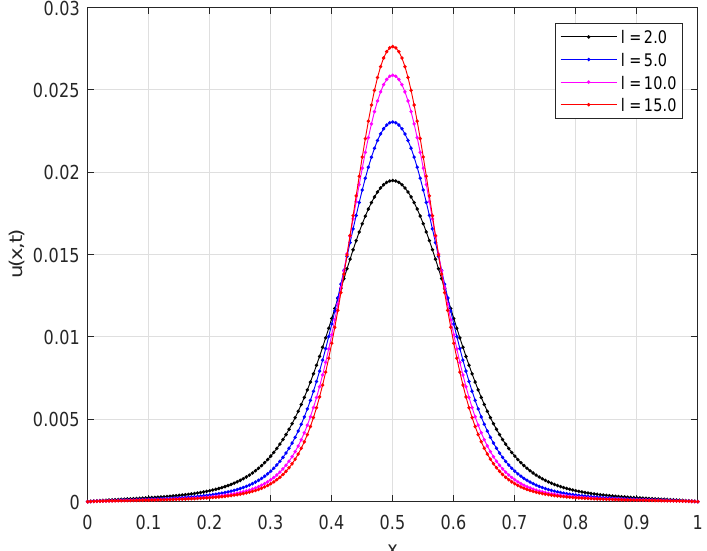
Figure 3. Example 1: Numerical solutions at t = 1 using δ 1 = 1.255 and δ 2 = 1.755 with h = k = 1/200, K = 1, and A 1 = A 2 = 1 for different values of l .